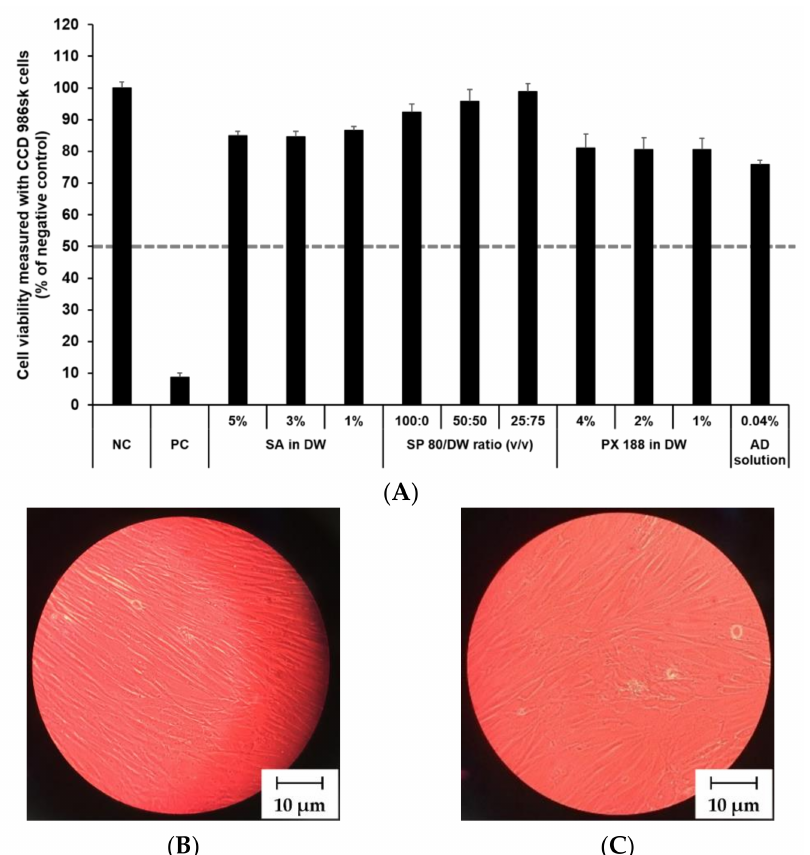
Figure 9. Irritation study and morphological evaluation using CCD 986sk cell line. ( A ) Viability of CCD 986sk cells treated with SLN components and AD solution, ( B ) the native morphology of CCD 986sk cells, and ( C ) nanoparticle-treated morphology of CCD 986sk cells. Cell viability was measured using MTT assay. The values greater than 50% (dotted line) indicate that test materials are non-irritant to the skin. Results are expressed as the means ± standard deviations of three independent experiments ( n = 3). NC: DPBS; PC: 5% SDS solution; SA: Stearic acid; DW: Distilled water; SP 80: Span 80; PX 188: Poloxamer 188; AD: